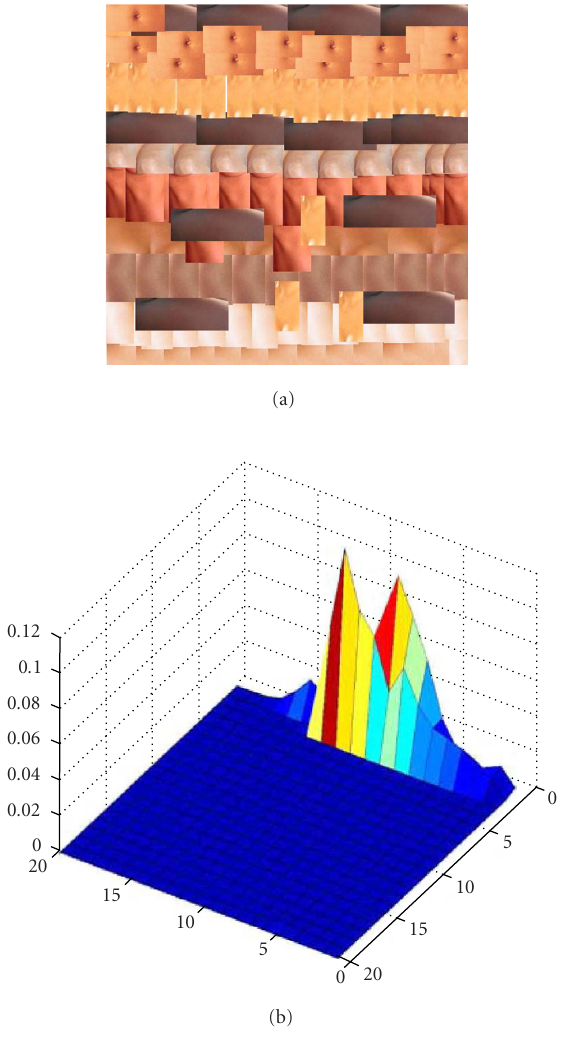
Figure 1: (a) Examples of skin tones obtained from various individ- uals with various complexions. (b) The HS histogram model con- structed from picture in (a).